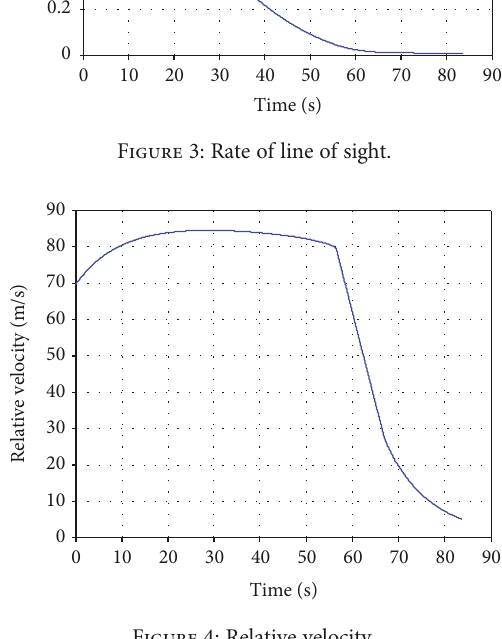
Figure 4: Relative velocity.